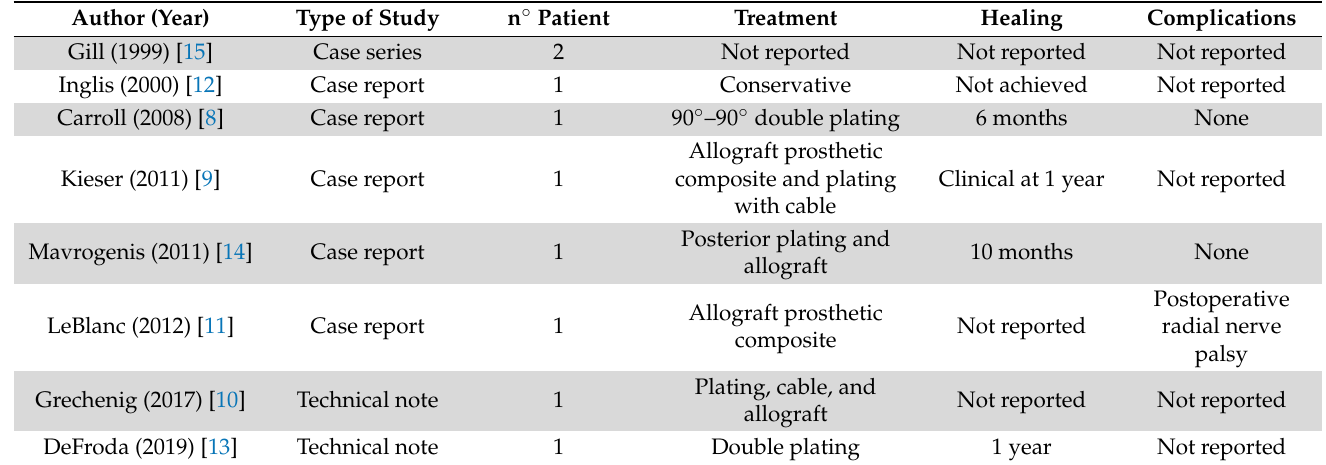
Table 1. Papers included in the review regarding IHFs and their